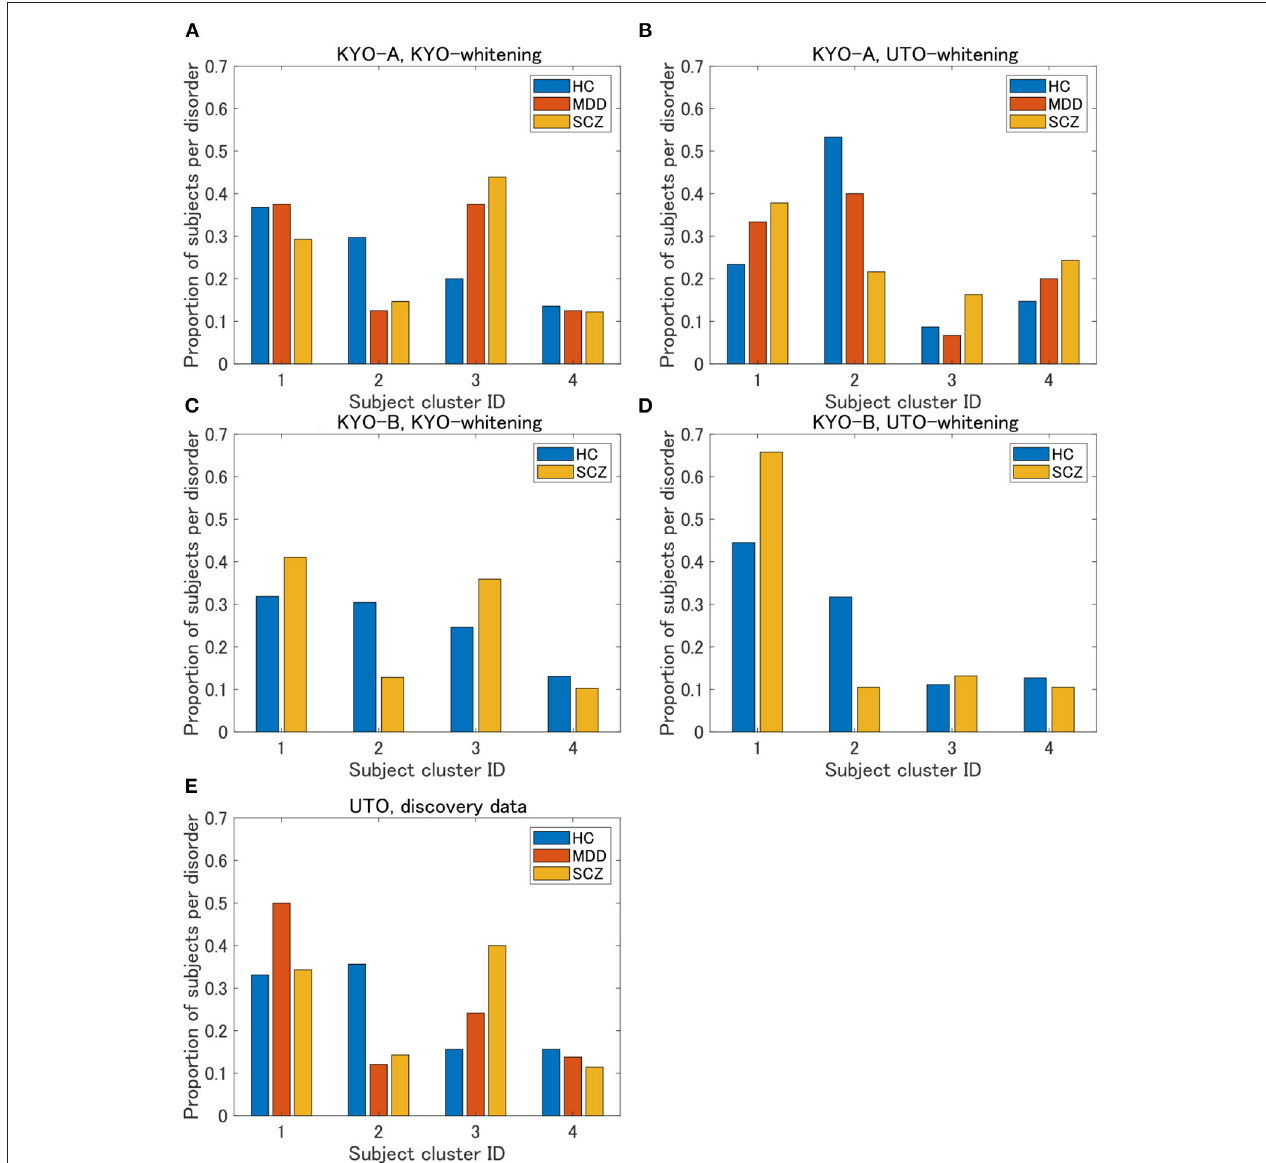
FIGURE 6 | Results of validation for KYO data. (A,B) Proportion of subjects per disorder of KYO-A data with KYO-whitening and with UTO-whitening, respectively. (C,D) Similar graphs for KYO-B data. (E) Proportion of subjects per disorder of UTO data. This is a copy of Figure 3A , but to compare with the results of the KYO data, the proportion is displayed only for HC, MDD, and